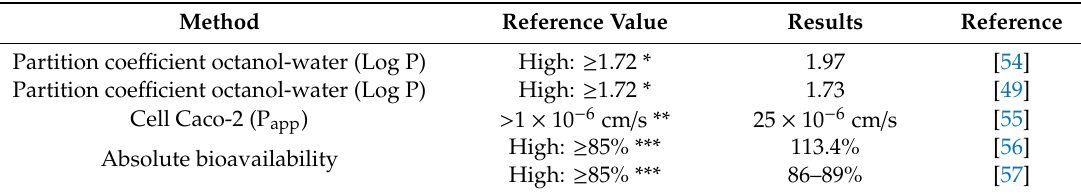
Table 2. Permeability data obtained for